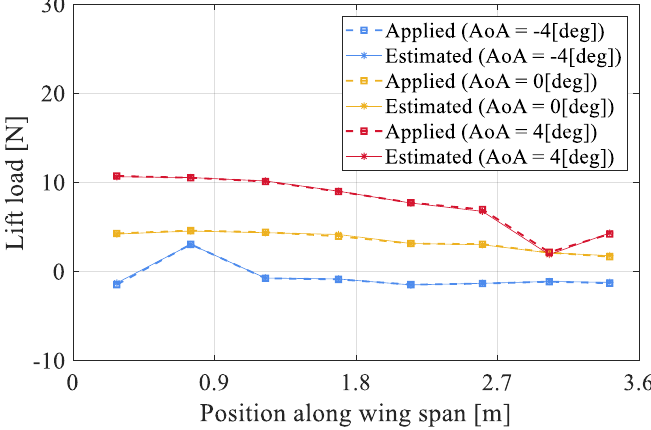
Figure 9. Load identification results in “aligned” test case (AoA = 0°) and “single” test case (AoA = − 4° and 4°). Flap 2 angle 15° when AoA = − 4°, and Flap 7 angle − 15° when AoA = 4°.